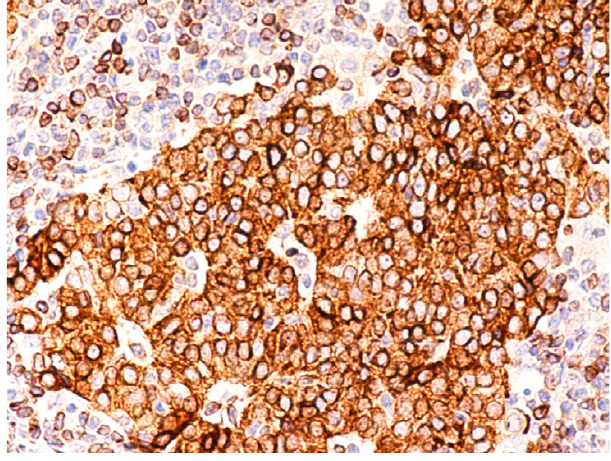
Figure 13 (B-SA, anti-CD57, × 400): Type B3 thymoma. Note strong expression of CD5 in neoplastic epithelial cells and back- ground lymphocytes.